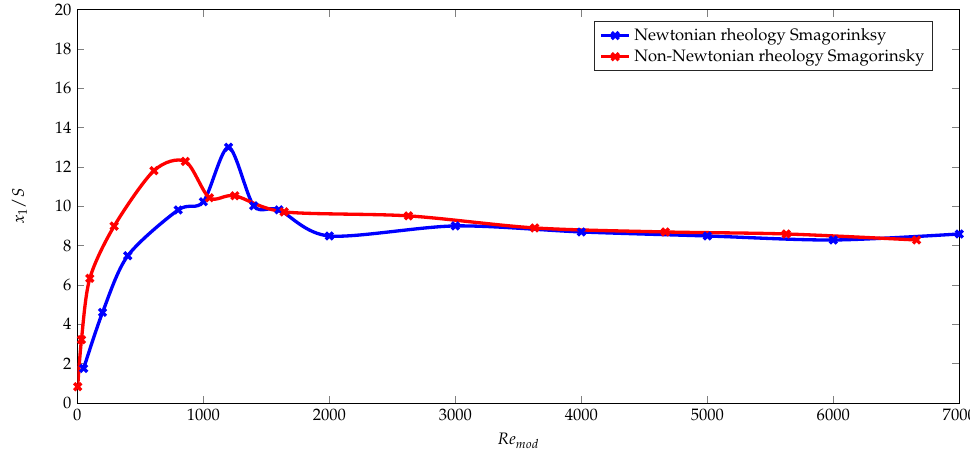
Figure 18. x 1 / S of Newtonian and shear-thinning blood rheology plotted against modified Reynolds number Re mod .